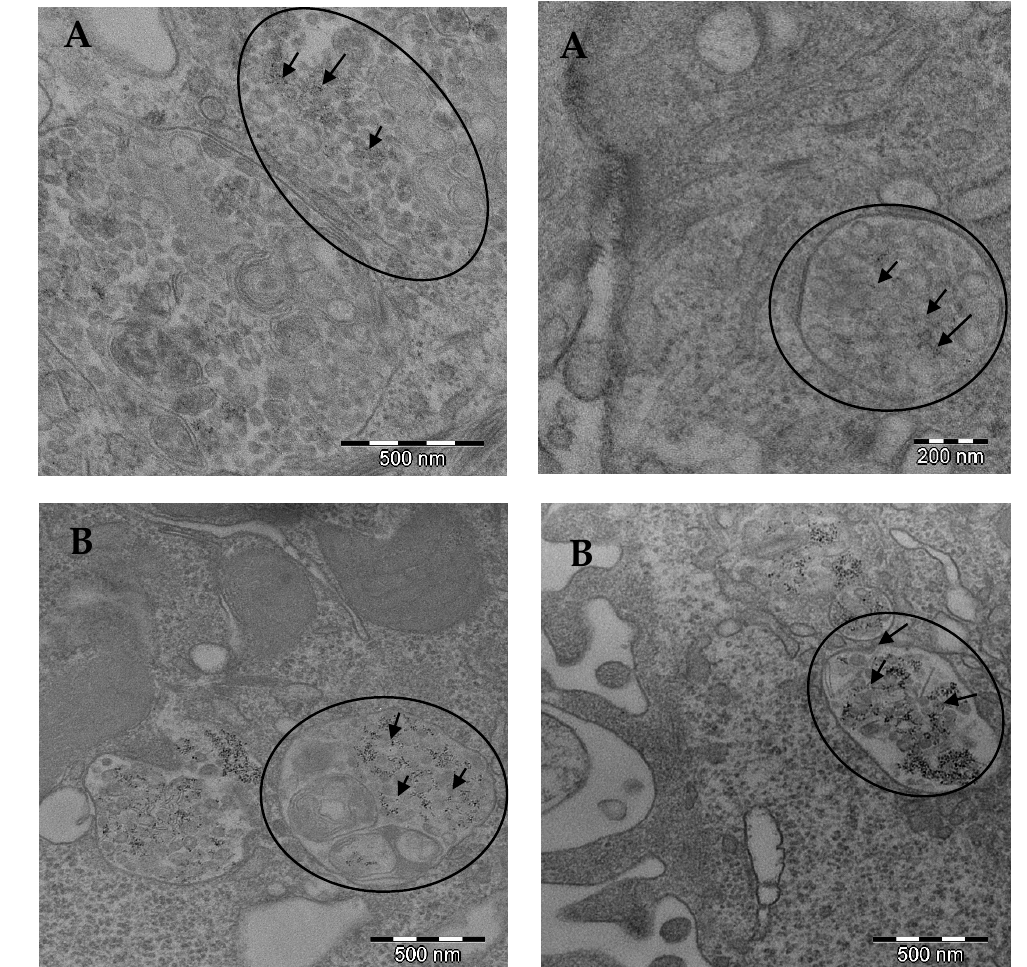
Figure 1. TEM images of cultured cells HT-29 exposed to ( A ) 0.5 mmol L − 1 4 nm iron nanoparticles (FeNPs) and ( B ) 0.5 mmol L − 1 Venofer ® . Ellipses highlight the presence of mitophagy processes. Arrows highlight the presence of nanoparti- cles.